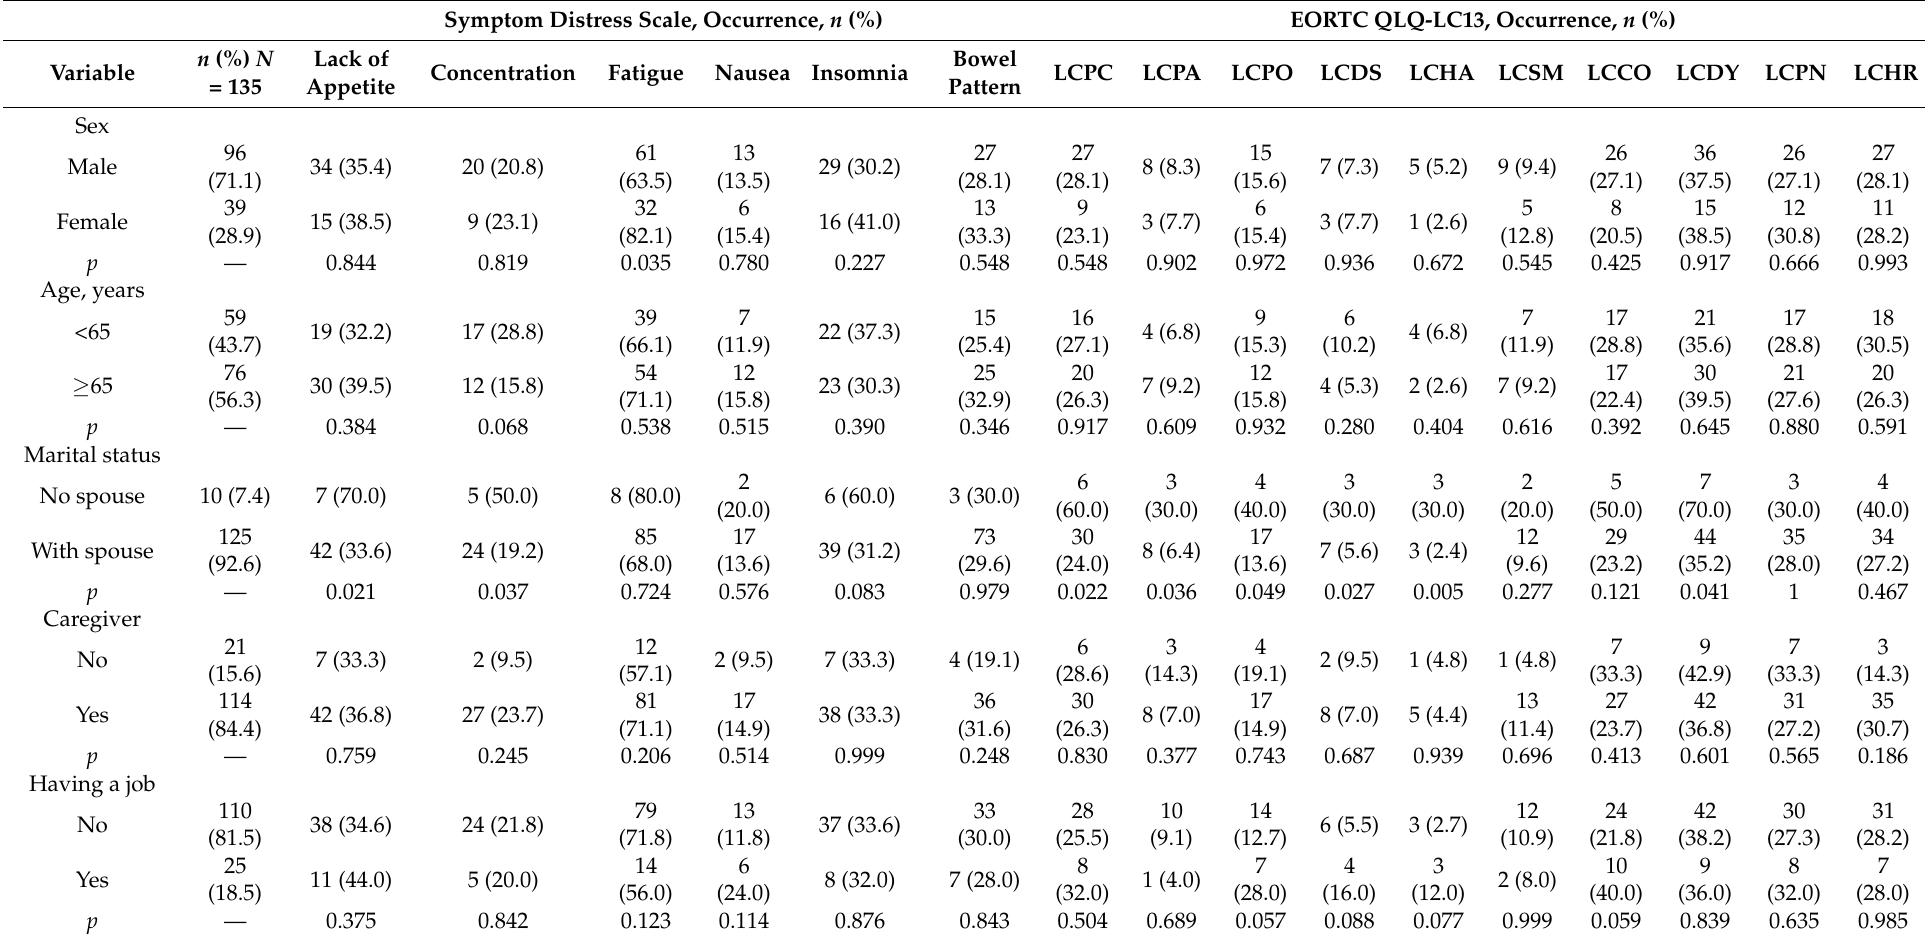
Table 1. Association between sociodemographic and clinical characteristics and symptom